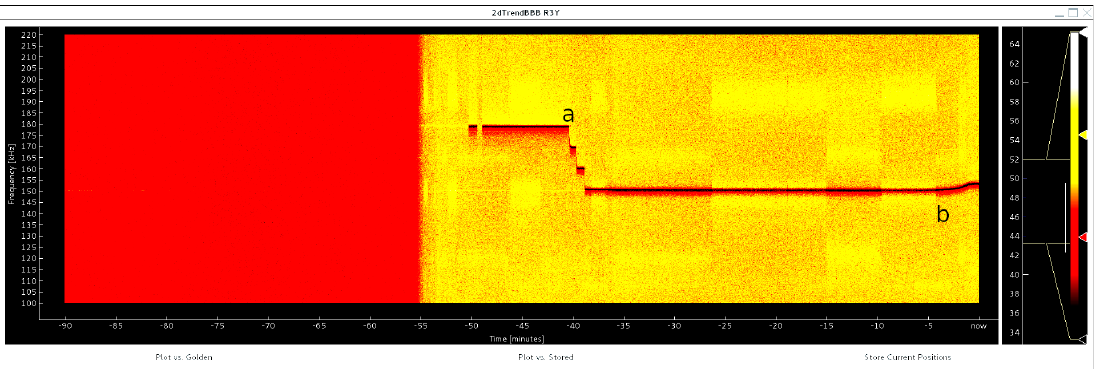
Figure 6. The figure shows in the vertical axis the oscillation frequency (in kHz) in the vertical plane as measured by the BBB system as a function of time in the horizontal axis (in minutes). Starting approximately at − 40 min (point “a”), the Master Oscillation (MO) radio frequency (RF) of the 3 GeV storage ring is manually increased in steps of 5 Hz is in order to change the vertical betatron tune. At − 5 min (point “b”), one of the beamlines closes its undulator gap, which causes a visible perturbation.